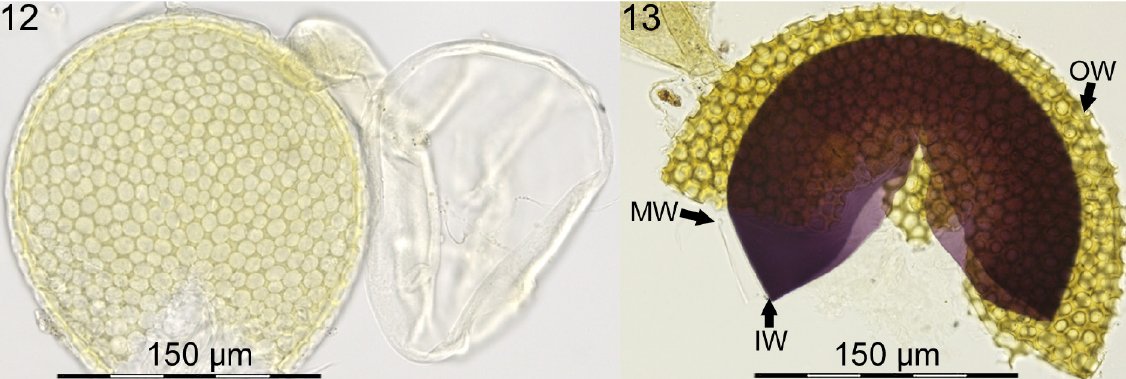
Figs. 12-13: Acaulospora excavata. 12. Young, crushed spore in PVLG formed laterally on the neck of a hyaline sporiferous saccule. The yellow spore wall layer is crowded by large pits on its outer surface. 13. Crushed spore in PVLG + Melzer’s reagent with three walls (OW, MW & IW). IW(L2) staining purple to dark purple in the presence of Melzer’s